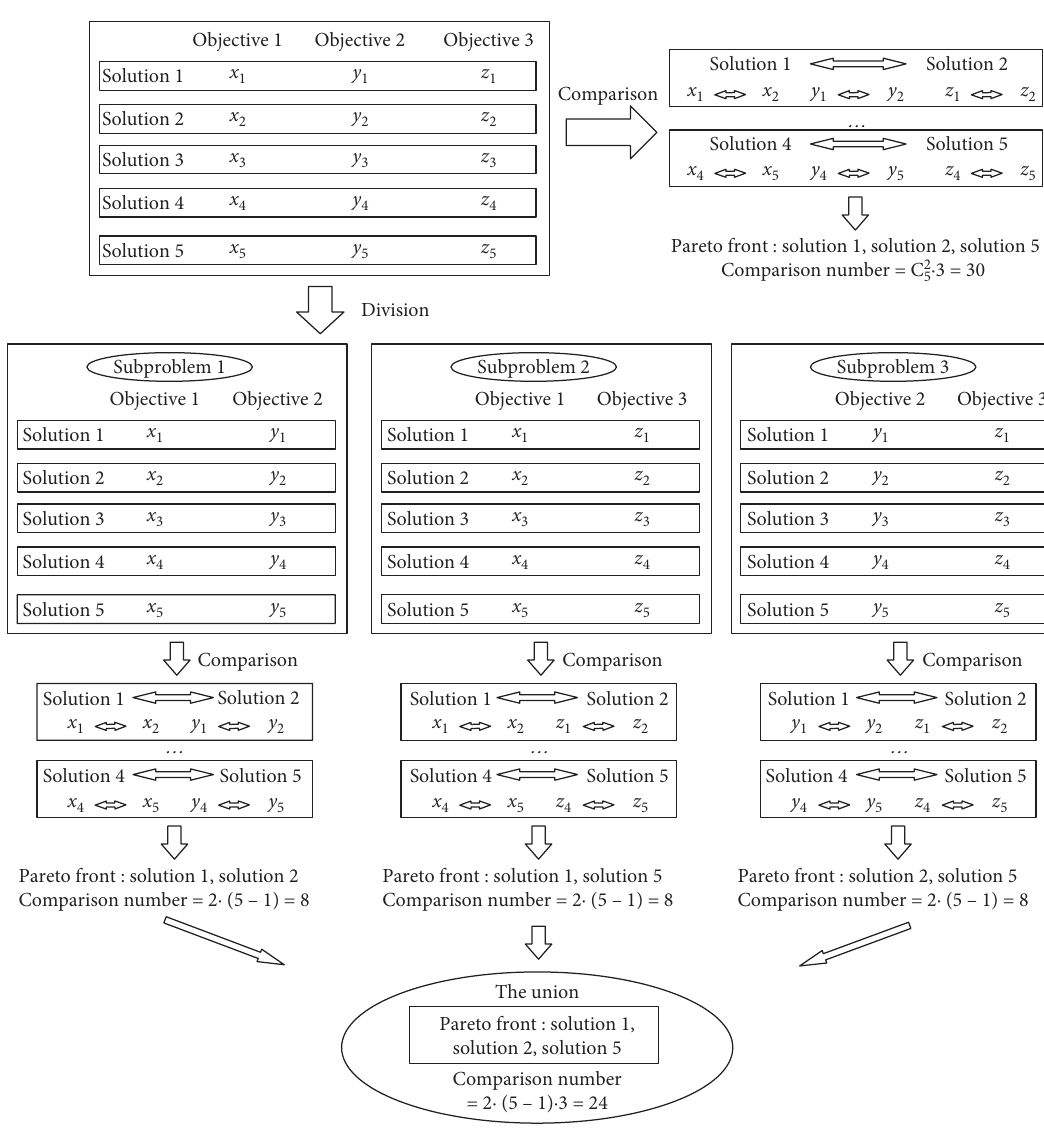
Figure 11: The example of the Pareto separation operator.